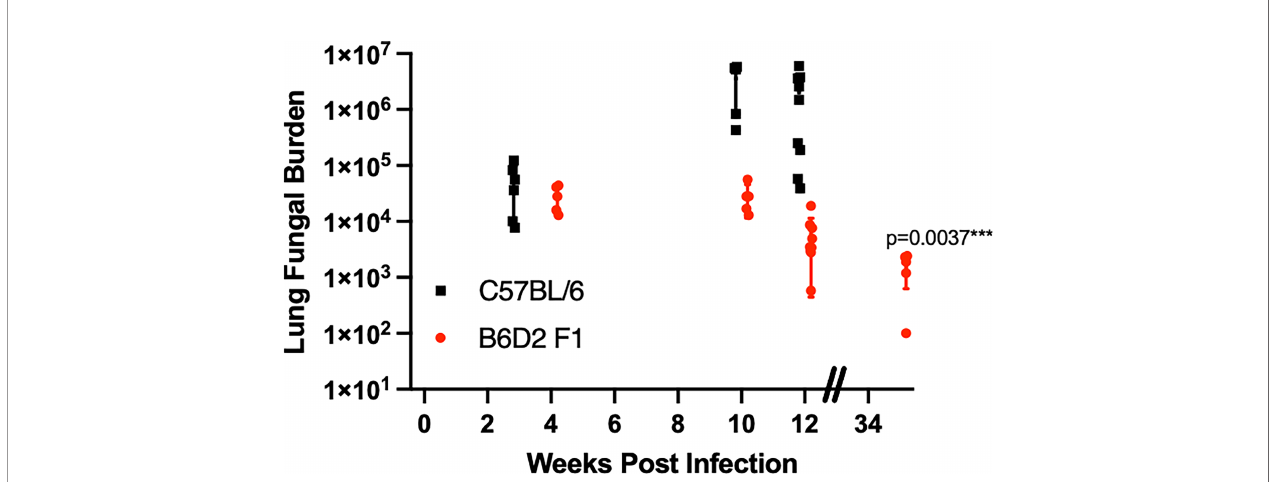
FIGURE 1 | B6D2F1 mice have controlled lung fungal burdens after Cp1038 infection. C57BL/6 (black squares) or B6D2F1 (red circles) were intranasally infected with ~50 arthroconidia of Cp1038. At the indicated time points, 5 – 9 mice from each group were sacri fi ced, and lung fungal burden was determined. Data are represented as mean with standard deviation. B6D2F1 burdens were analyzed for differences compared to the initial 4-week burden using a Kruskal – Wallis on log- transformed data. Figure is combined from three separate infections with various planned end